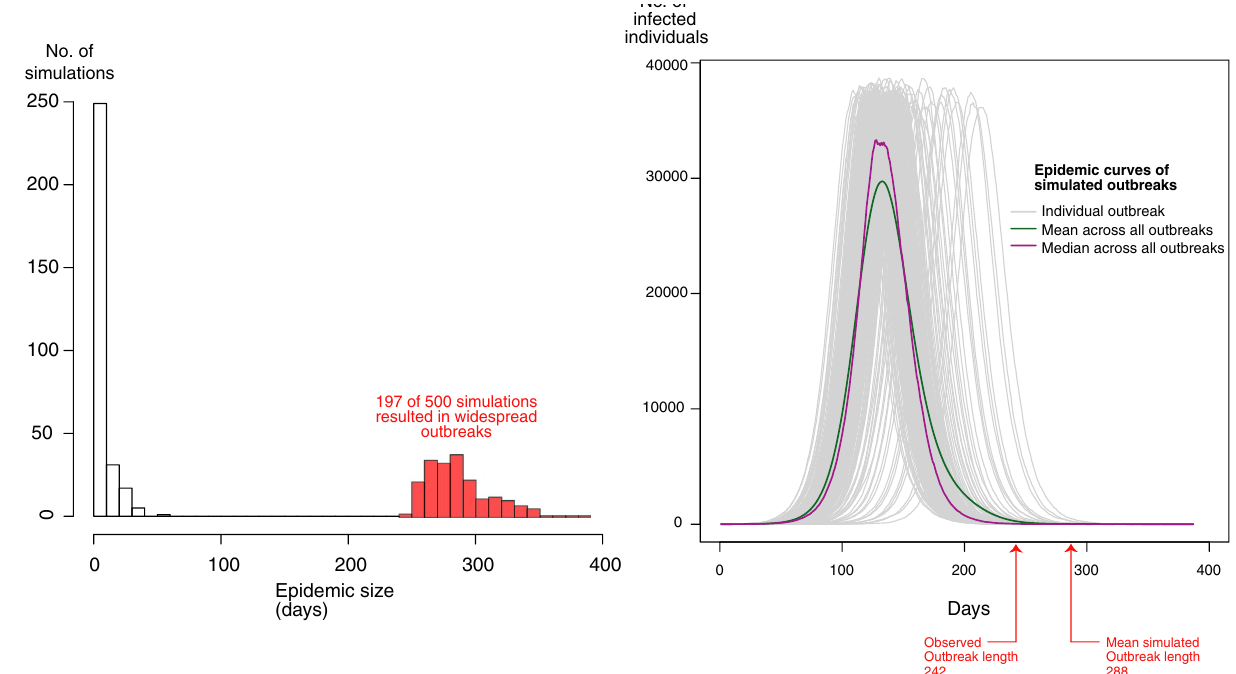
Figure 4. Left: Histogram of simulation lengths (epidemic sizes) of 500 simulations, 197 of which resulted in widespread geospatial outbreaks (infecting greater than 1,000 nodes corresponding to urban areas in Rwanda). Right: Infectious epidemic curves (progression of influenza infections over time) of the 197 simulations that resulted in widespread geospatial outbreaks. The red arrows point out the reported length of the observed 2009 pH1N1 outbreak in Rwanda (242 days) and the mean simulated outbreak length (287.8